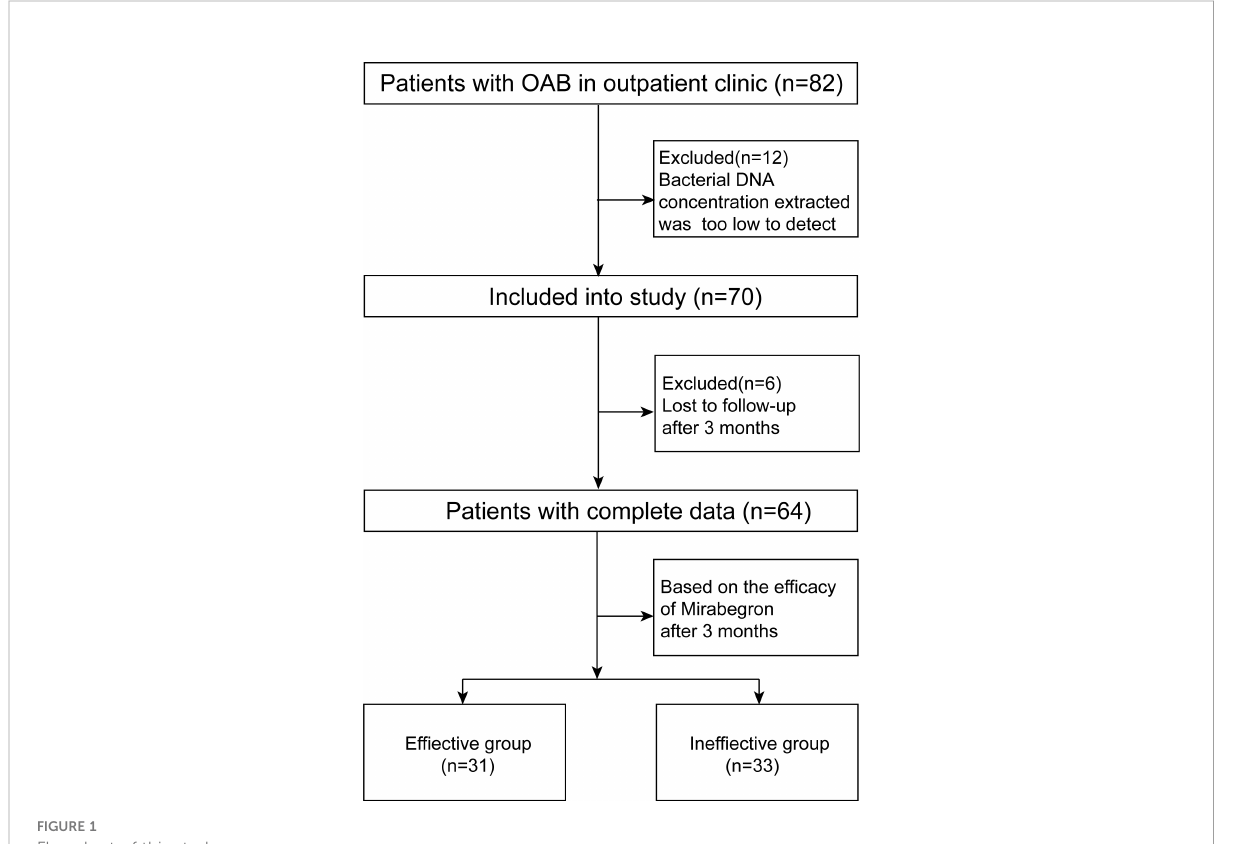
FIGURE 1 Flowchart of this